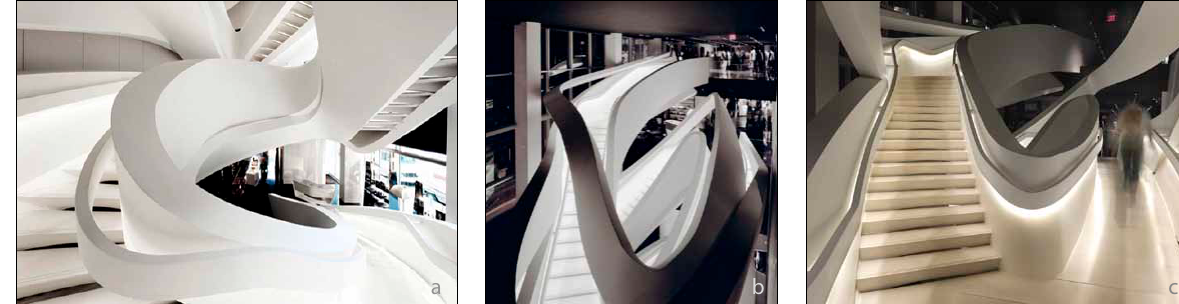
fig. 6. armani Store new York, 5th. avenue